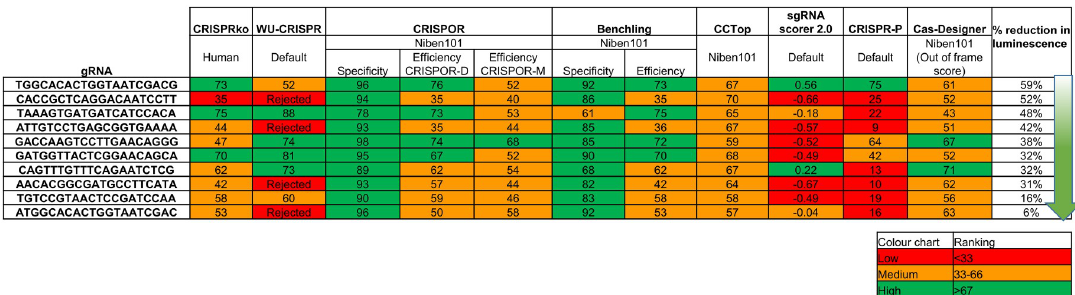
Fig 3. Summary of predicted gRNA rankings vs. observed percent reduction in luminescence of NanoLuc, measured 4 dpi in three biological replicates. NanoLuc luminescence measured in leaves infiltrated with p2X35S-NanoLuc-NOSt, p19 and a NanoLuc editing construct. Percentage reduction of luminescence due to editing of NanoLuc, calculated by setting luminescence of control leaves (infiltrated with p2X35S-NanoLuc-NOSt, p19 and an editing construct targeting an endogene in N . benthamiana ) to 100%. See S1 Data for luminescence measurements. Each gRNA ranking obtained from the online gRNA prediction tools is colour coded: red, orange and green depict low, medium and high editing efficiency,